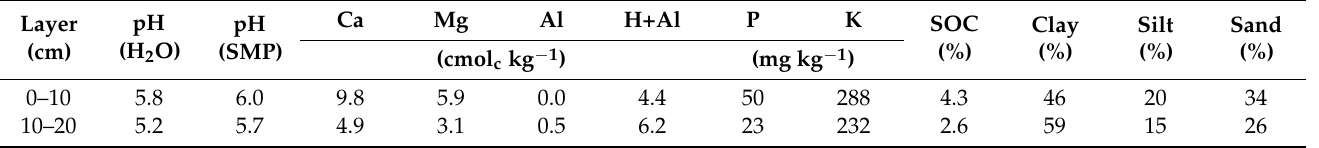
Table 2. Chemical and physical attributes of the 0–10 and 10–20 cm layers of the topsoil (Typic Hapludox) of the experiment area. Ibirub á , RS,